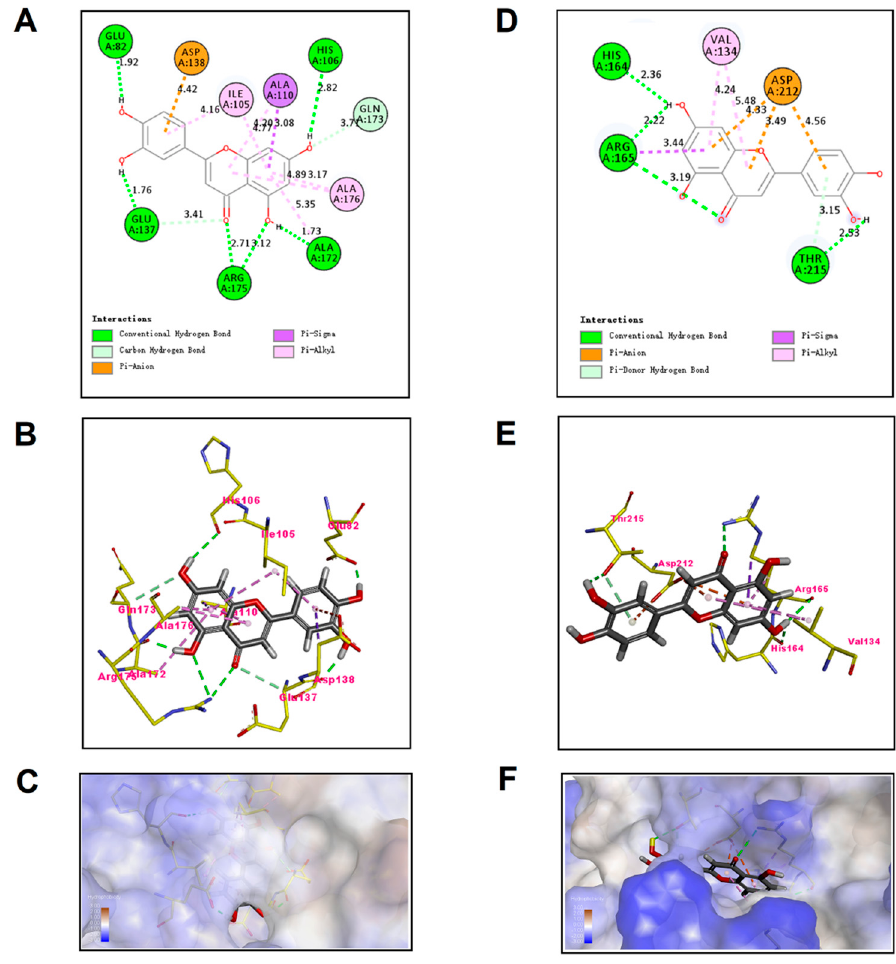
Figure 8. Predicted binding mode of luteolin docked into TatD DNases. ( A , D ) show the interactions between luteolin and TatD DNases in two-dimensional (2D) docking models, ( B , E ) show luteolin interacting with the amino acid residues located within the active sites of the TatD DNases pocket in three-dimensional (3D) docking models, ( C , F ) show binding locations of TatD DNases interacting with luteolin as molecular surface structures.